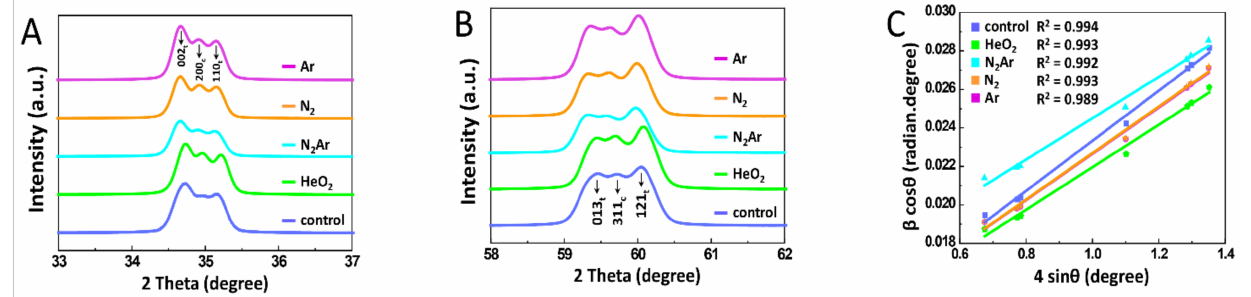
Figure 4. X-ray diffraction (XRD) patterns of zirconia specimens with each plasma gas ( A ) in